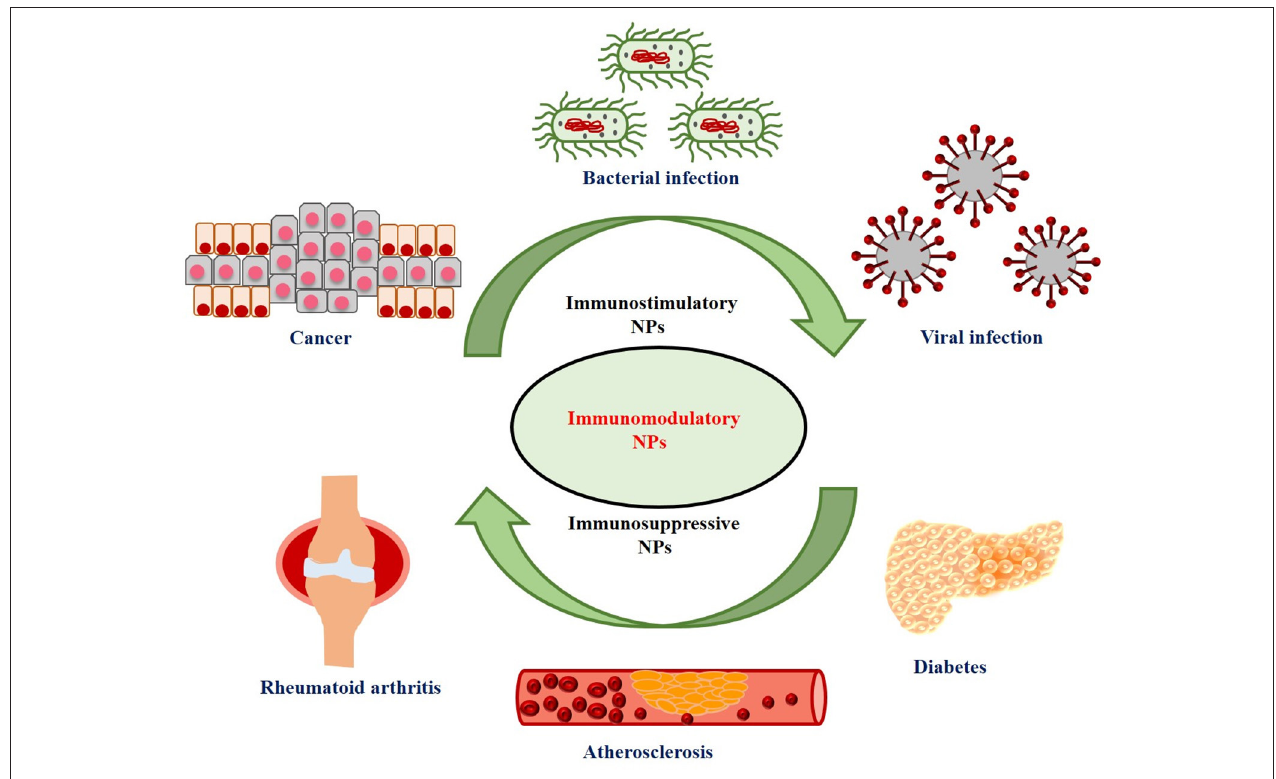
FIGURE 1 | Applications of immunostimulatory and immunosuppressive nanoparticles (NPs) for the treatment of various